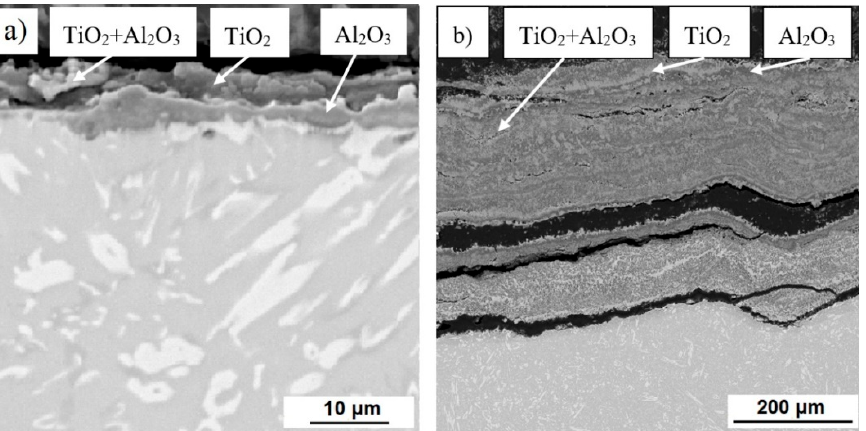
Figure 11. Microstructure (SEM-BSE) of oxide layers of TiAl35Si5 alloy, prepared by centrifugal casting, after cyclic oxidation at ( a ) 800 °C and ( b ) 1000 °C for 400 h.